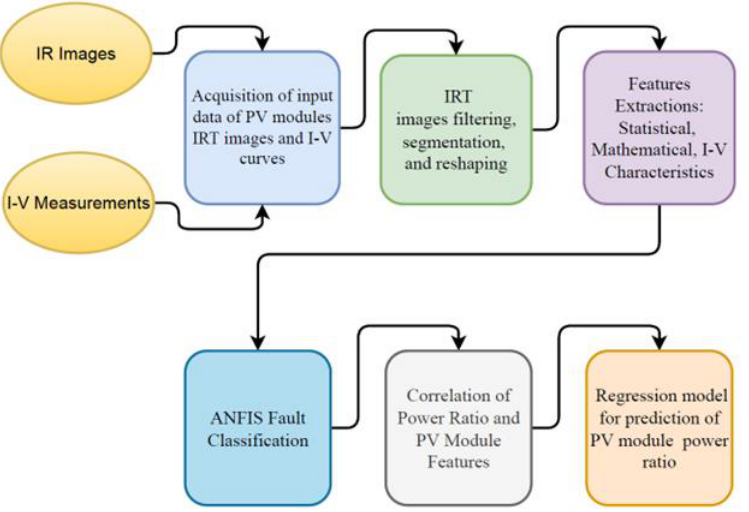
Figure 1. Procedure of development of ANFIS scheme for automation of fault detection and classi- fication.